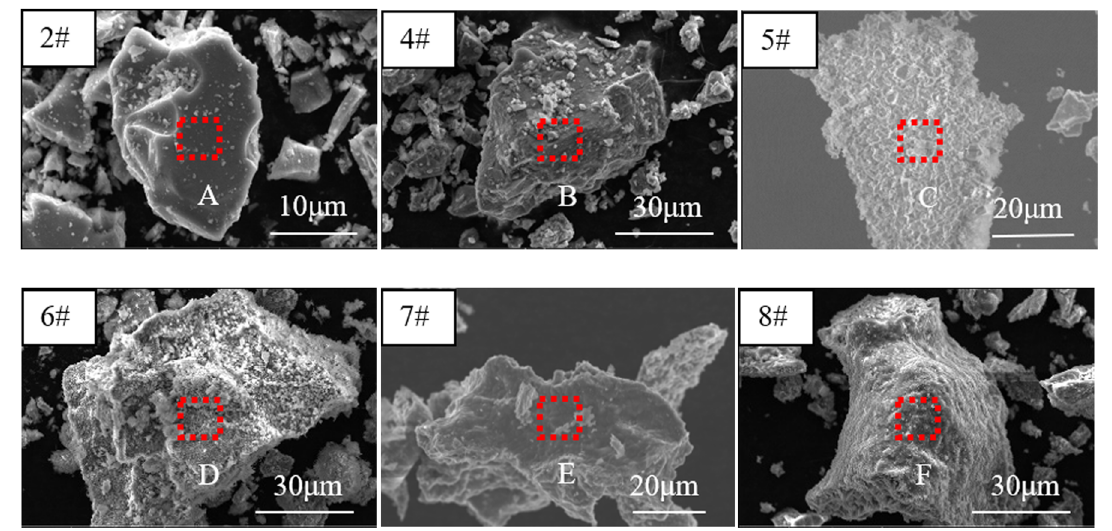
Figure 5: Microstructure of products before